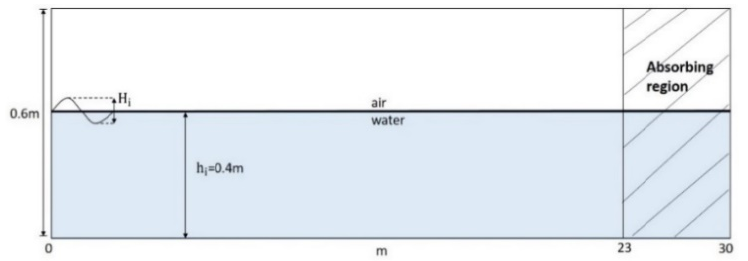
Figure 2. Sketch of the computational domain for the linear wave generation.